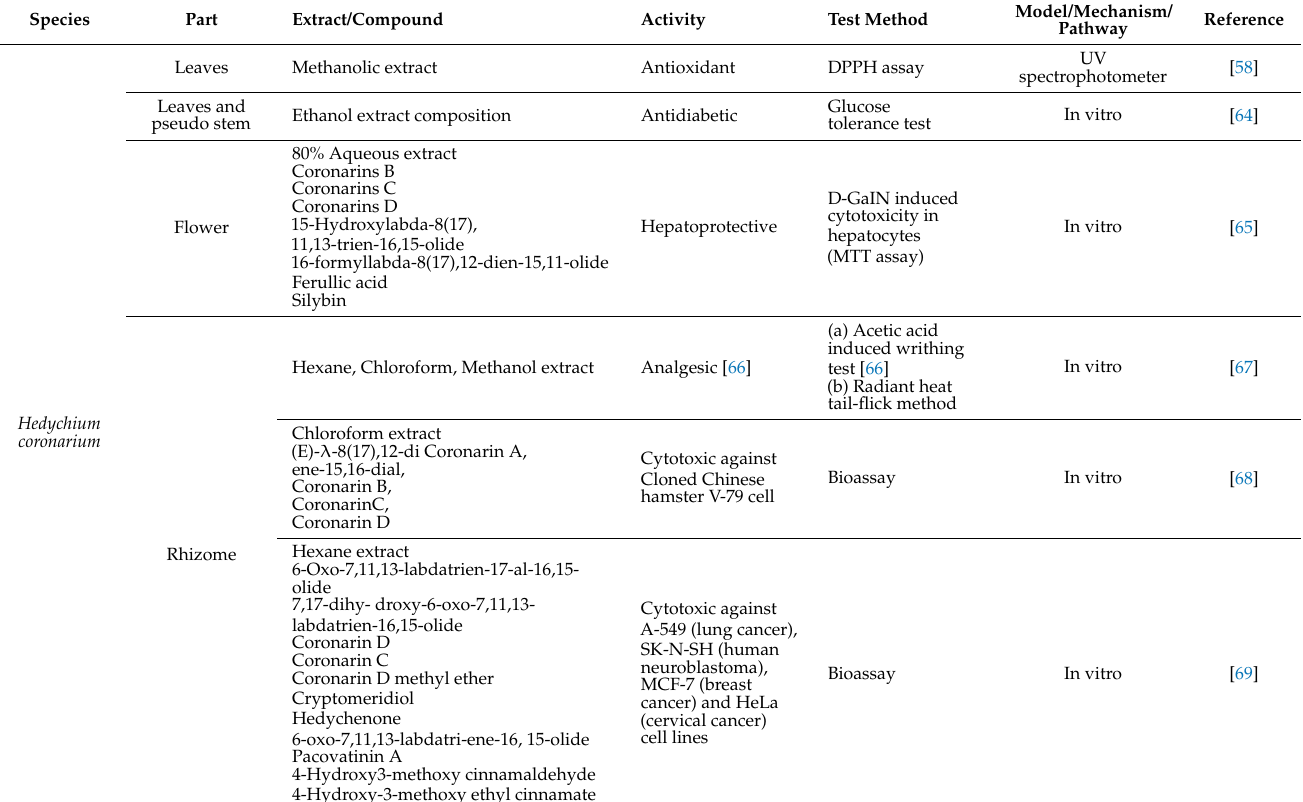
Table 5. Pharmacological activity of chemical constituents of Hedychium species